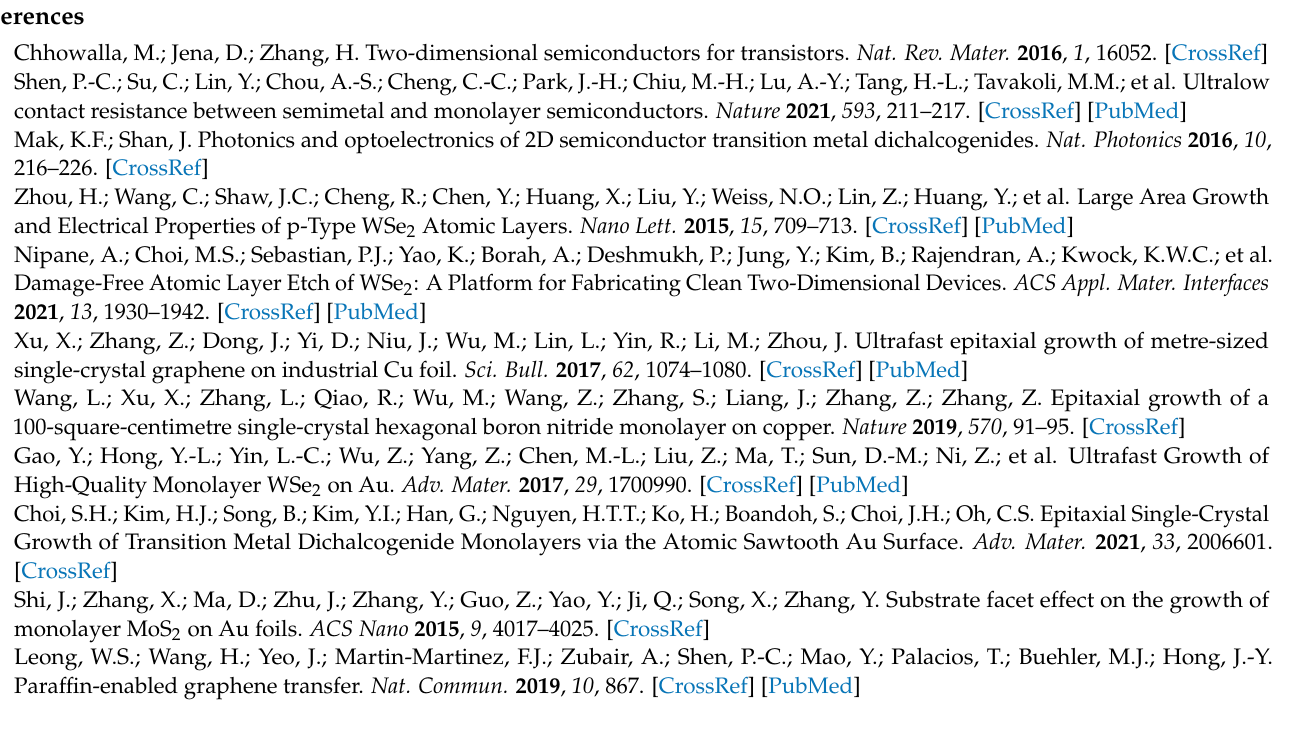
height profile acquired along the yellow section dash line. Figure S3. High-magnification optical microscopic image of the as-grown monolayer WSe 2 film on SiO 2 /Si substrate. Figure S4. Contrast analysis results of the diffraction spots using STEM. Figure S5. The top view pictures of the sand- wich structure corresponding to the different stages labeled with different colored rectangle marks. Figure S6. (a) Cross-section STEM images of as-prepared WSe 2 /Au sample. (b) STEM image of inner Au foil. Figure S7. (a) Cross-sectional TEM image and corresponding AFM picture of PMMA layer after Au etching. (b) Height of PMMA thin film via AFM. Figure S8. I ds -V ds output characteristics of back-gate WSe 2 FETs with conventional thermal deposition method measured within several weeks. Figure S9. (a) Time-dependent dynamic photoresponse under different wavelength incident light illumination with a power density of 3.06 mW/cm 2 at V ds = 1 V. (b) Transient response of the transfer-free monolayer WSe 2 -based photodetectors at V ds = 1 V under 532 nm incident light illumination with a power intensity of 3.06 mW/cm 2